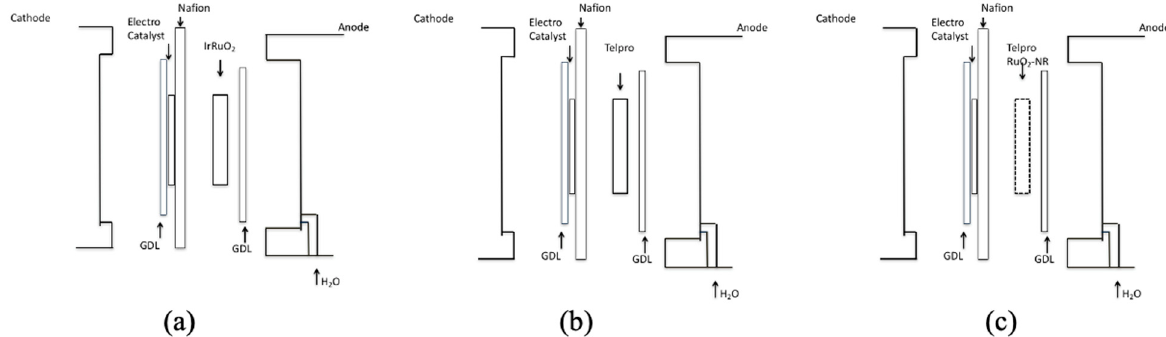
Figure 4. ( a ) PEM electrolyzer with detached anode electrocatalyst (IrRuO 2 ) and GDL, ( b ) PEM electrolyzer with detached anode electrocatalyst (Ir/Ta on Telpro) and GDL, and ( c ) PEM electrolyzer with detached anode electrocatalyst (IrTa and RuO 2 NRs on Telpro) and GDL.